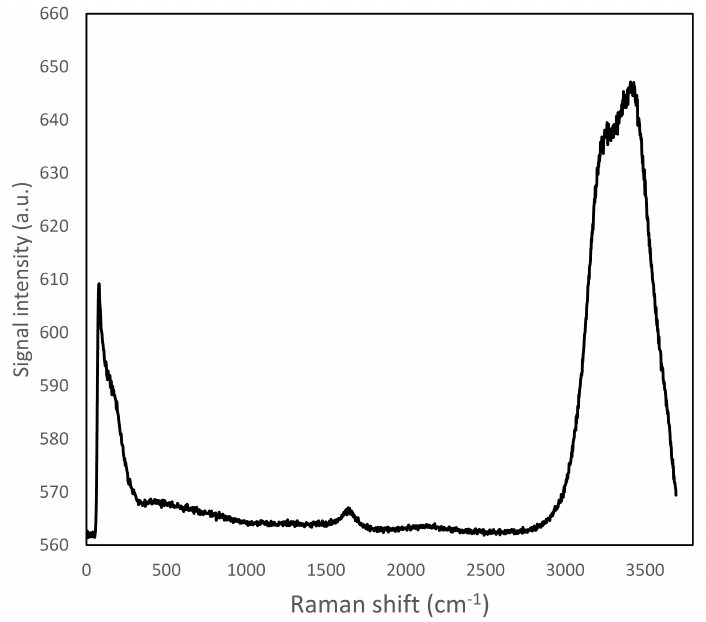
Figure 1. Raman spectrum of ultra-pure water; a large emission band can be viewed in the region around 2900–3800 cm − 1 .